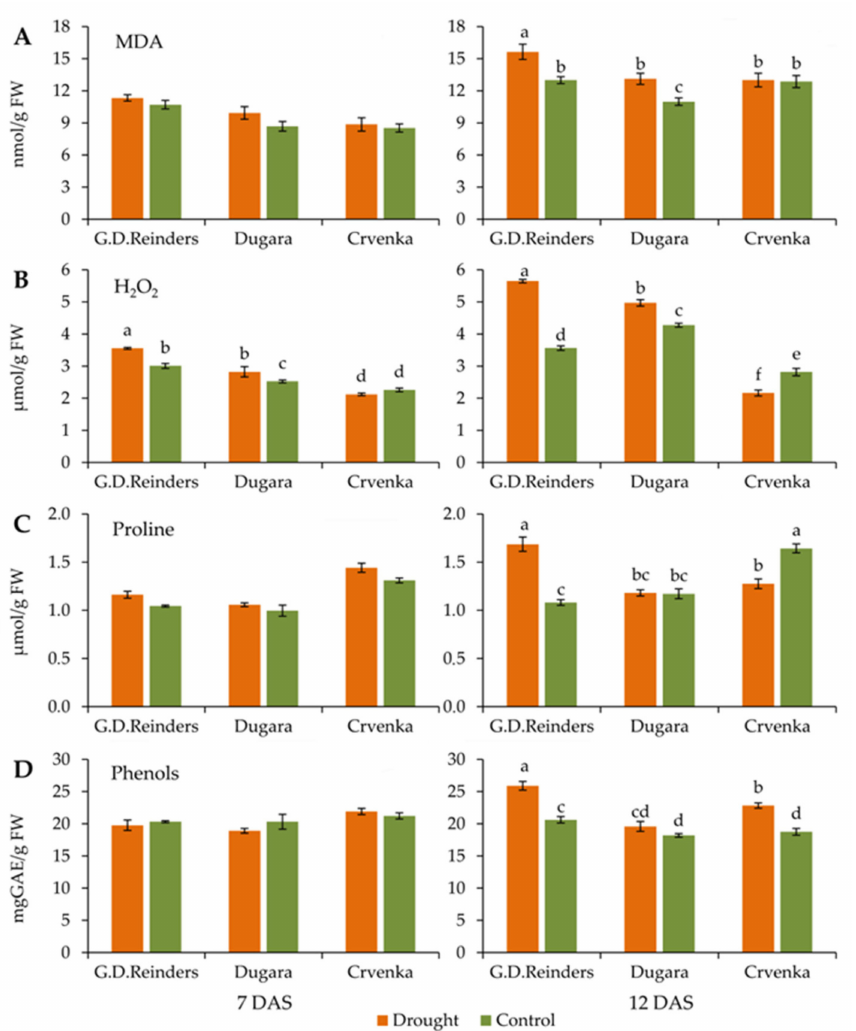
Figure 5. Malondialdehyde (MDA) ( A ), hydrogen peroxide (H 2 O 2 ) ( B ), proline ( C ) and phenols ( D ) contents measured in control and drought-stressed apple cultivars (“Golden Delicious Reinders”, “Crvenka” and “Dugara”) at 7 and 12 DAS (day after stress). Values are mean ± SE ( n = 5). Different letters indicate significant differences among treatments and cultivars at p < 0.05 according to the LSD